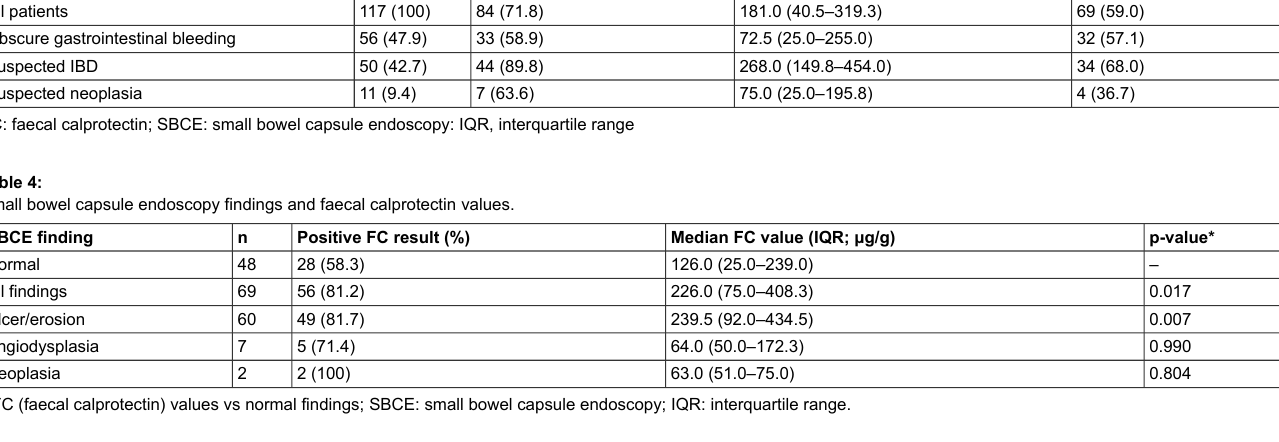
Table 3: Small bowel capsule endoscopy indications and faecal calprotectin values. SBCE indication